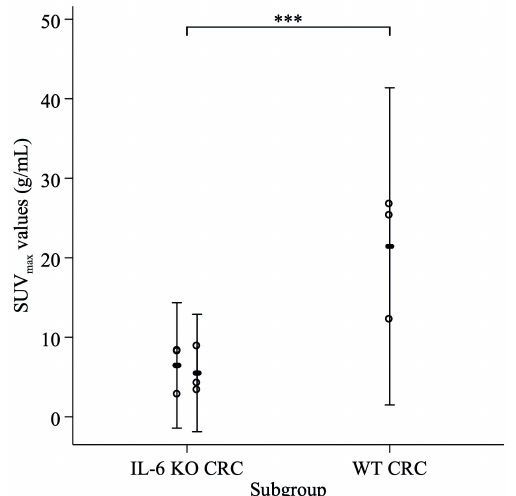
Figure 8. FDG uptake comparison in the highly avid tumor foci in the WT animal and the two IL-6 KO animals, mixed e ff ects model. Hollow markers: SUV max values of three most avid focal regions. Range plot: SUV max mean, 95%CI by animal. *** Mixed e ff ects model, fixed e ff ect of IL-6 status (IL-6 KO vs. WT): p < 0.001.